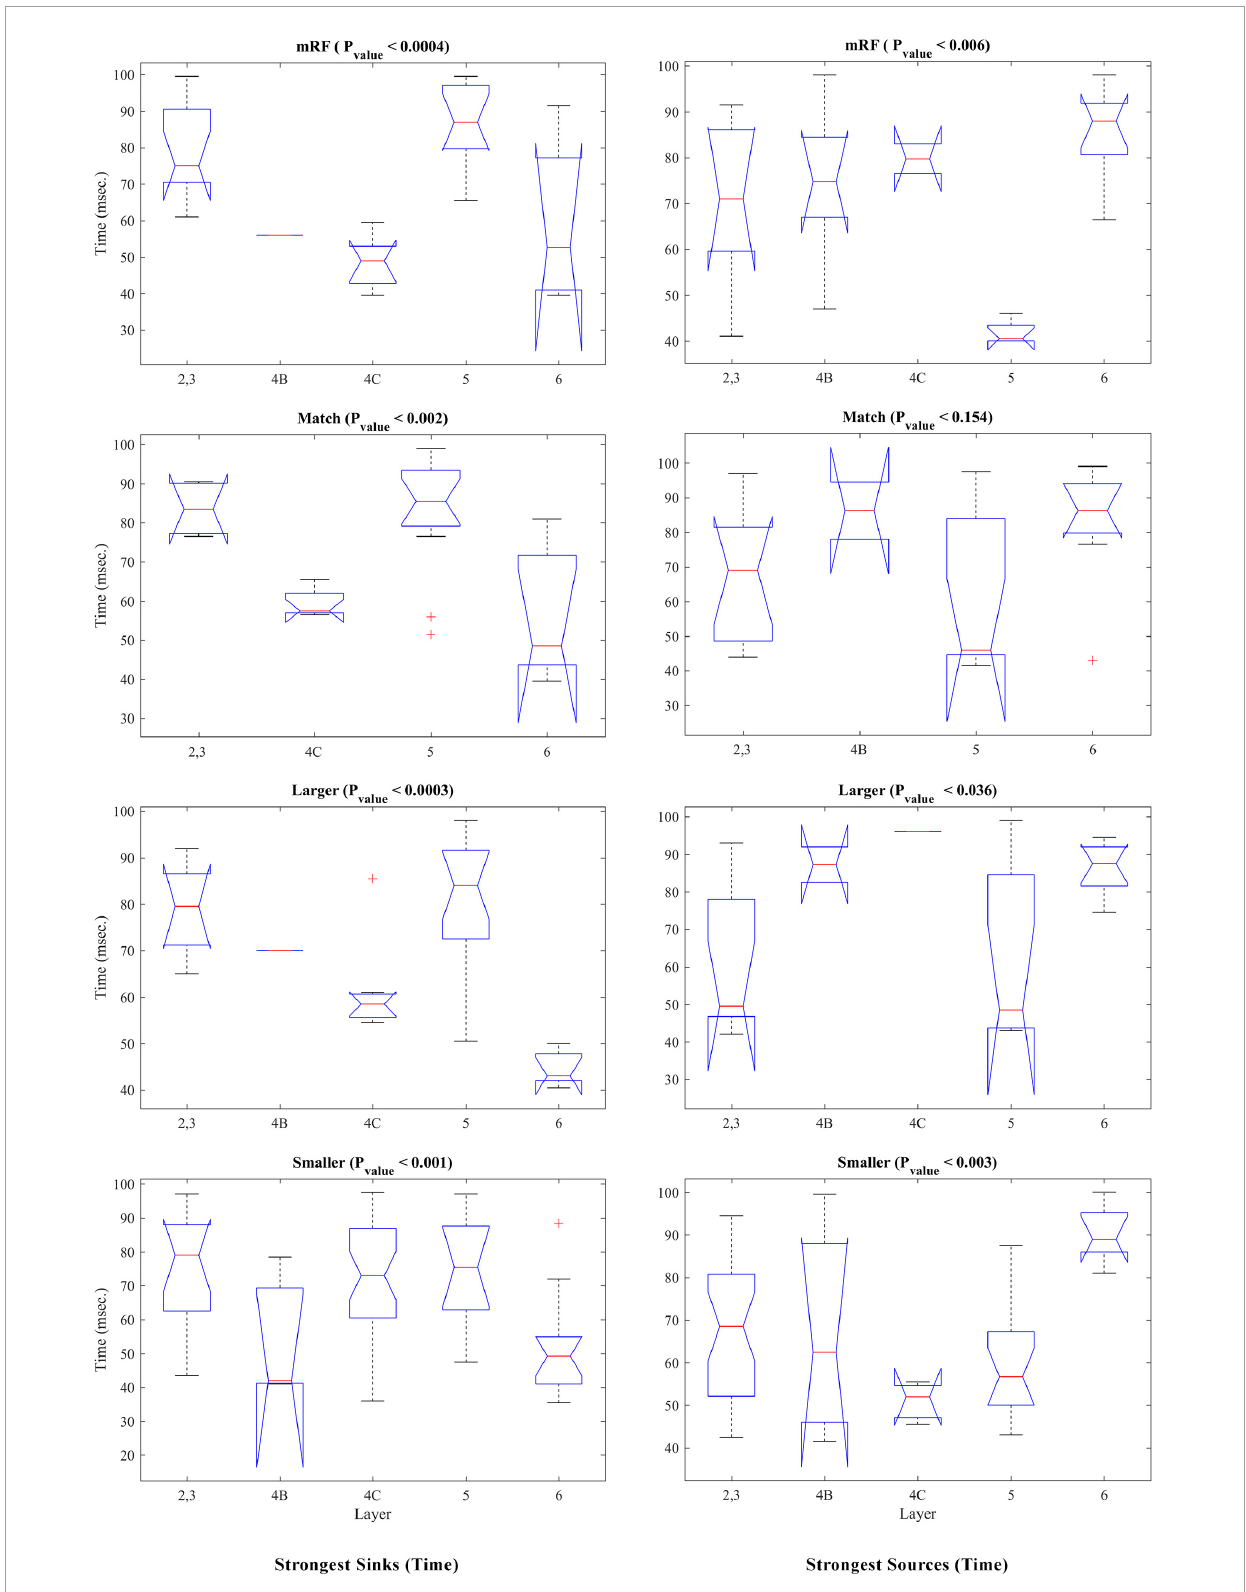
FIGURE6 Kruskal–Wallis test of strongest sinks and sources from the perspective of times of occurrence. The (left, right) columns refer to the sink and source time tests, respectively. Each row shows a type of stimulus indicated above it. The number of layers is specified on the X-axis and the Y-axis shows the time in milliseconds. At the top of each figure, the type of stimulus and the P value of the statistical test are